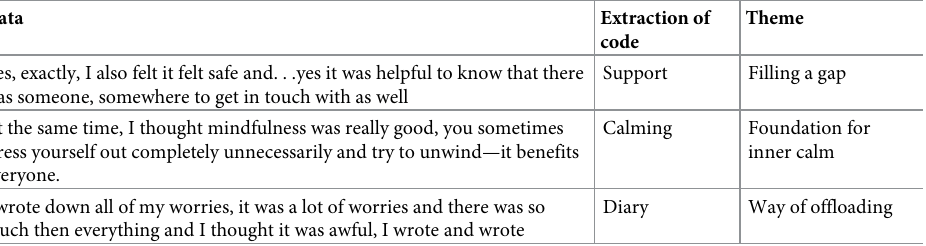
Table 1. Example of the data